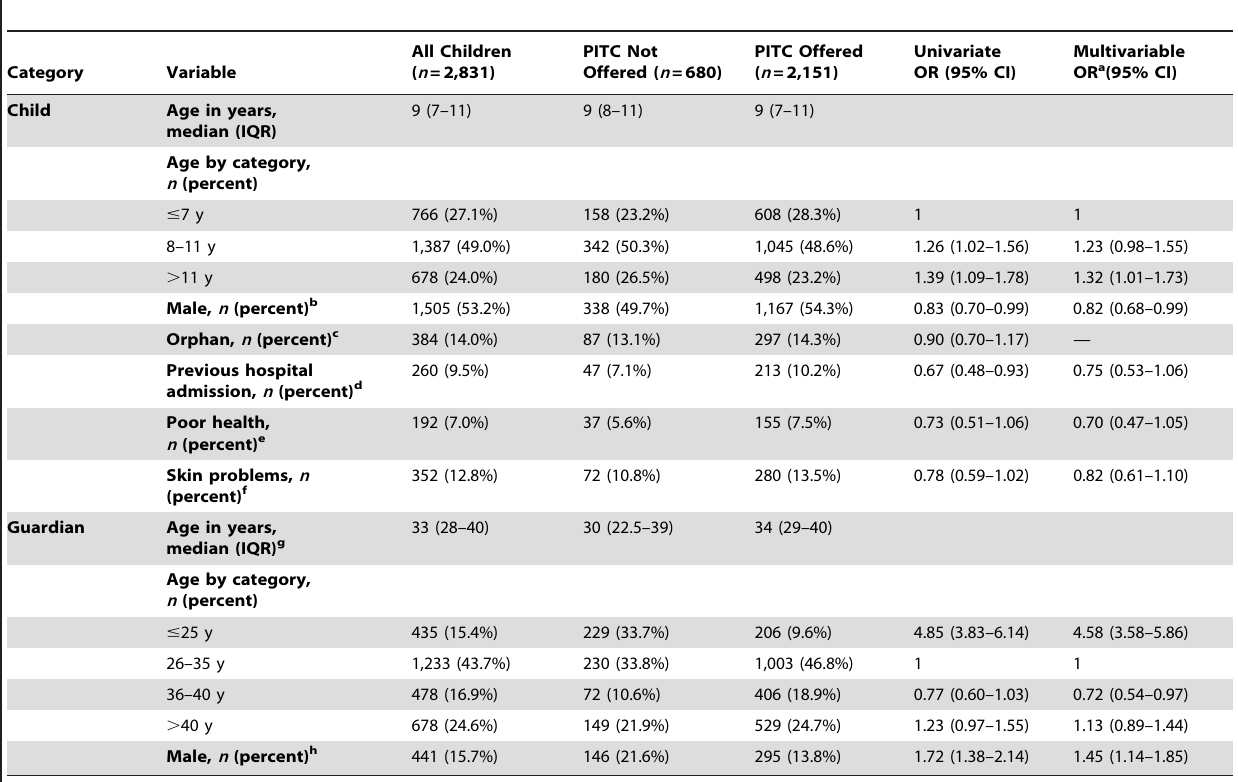
Table 1. Association between baseline variables and not being offered HIV testing by clinic providers.